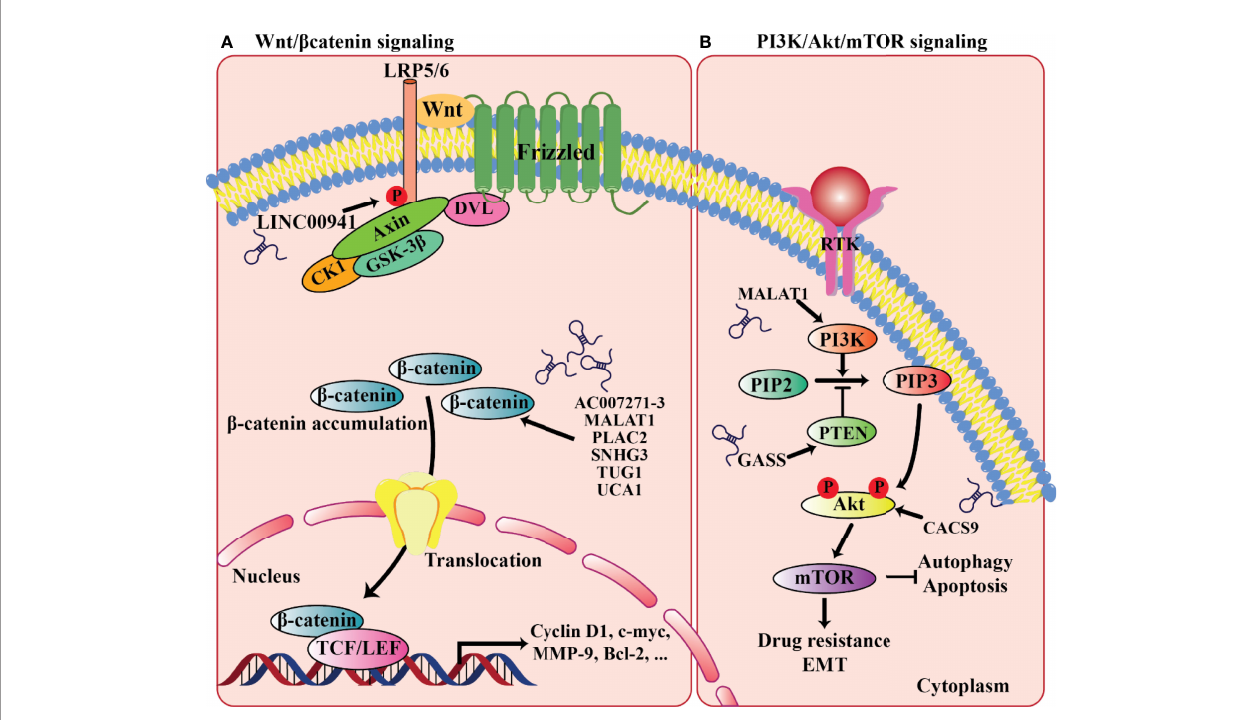
FIGURE 2 | LncRNAs involved in the relevant signaling pathways implicated in oral cancer progression. (A) Wnt/ b -catenin signaling. (B) PI3K/AKT/mTOR